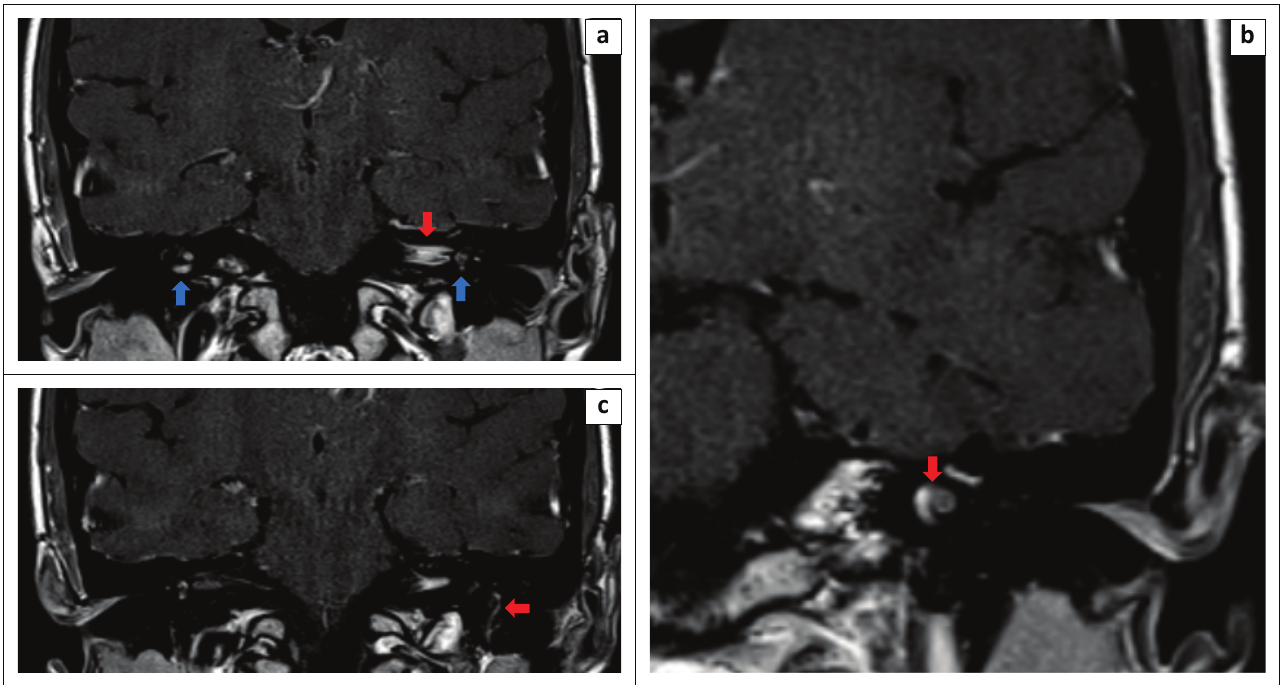
FIGURE 3: (a) Coronal, T1 weighted post contrast MRI demonstrated enhancement in left internal acoustic canal and facial nerve (red arrow) as well as bilateral basal turns of the cochleae (blue arrows). (b) Coronal, T1 weighted post contrast MRI demonstrated enhancement of bilateral basal turns of the cochleae (only left side shown, indicated by red arrow). (c) Coronal, T1 weighted post contrast MRI demonstrated enhancement of the left 7th cranial nerve vertical segment with a nodular appearance (red